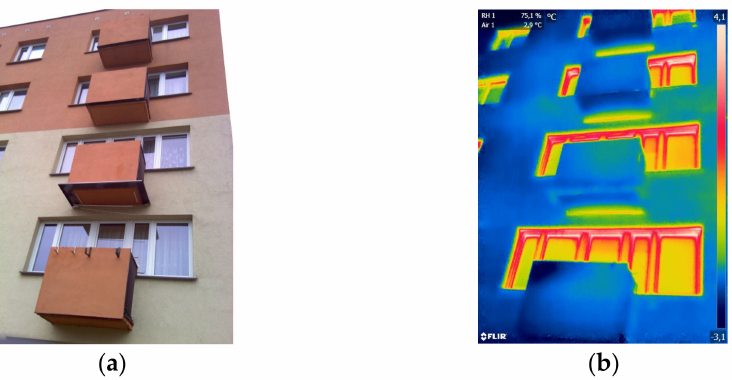
Figure 2. Fragment of the balcony facade of one of the analyzed large-panel residential buildings (OWT-67 system): ( a ) Photography; ( b ) Thermal image taken of the external wall surfaces of the building.